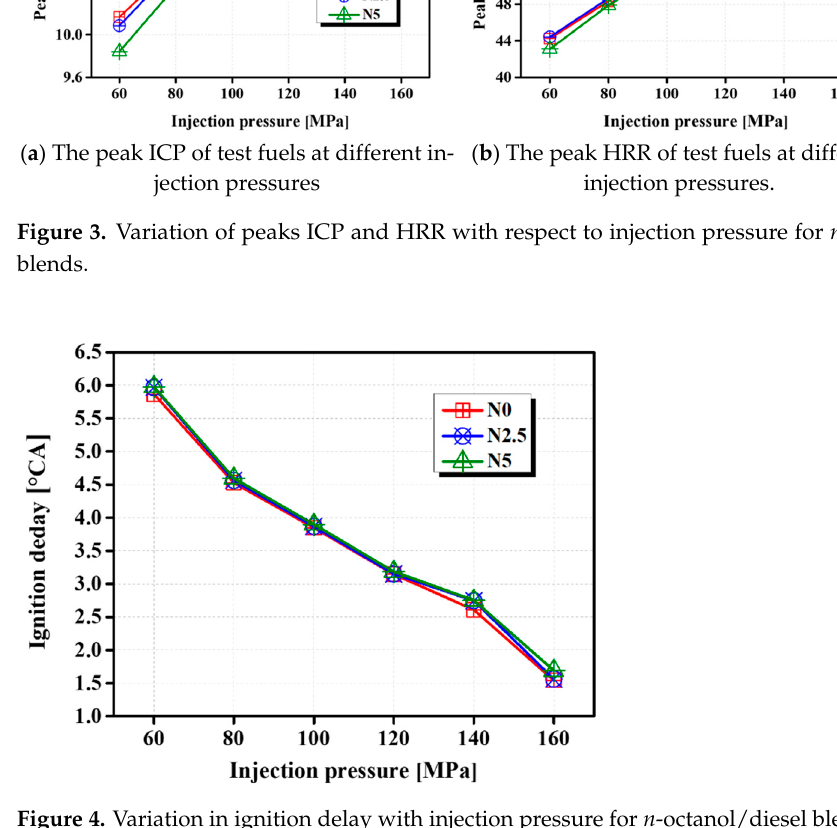
Figure 4. Variation in ignition delay with injection pressure for n -octanol/diesel blends.